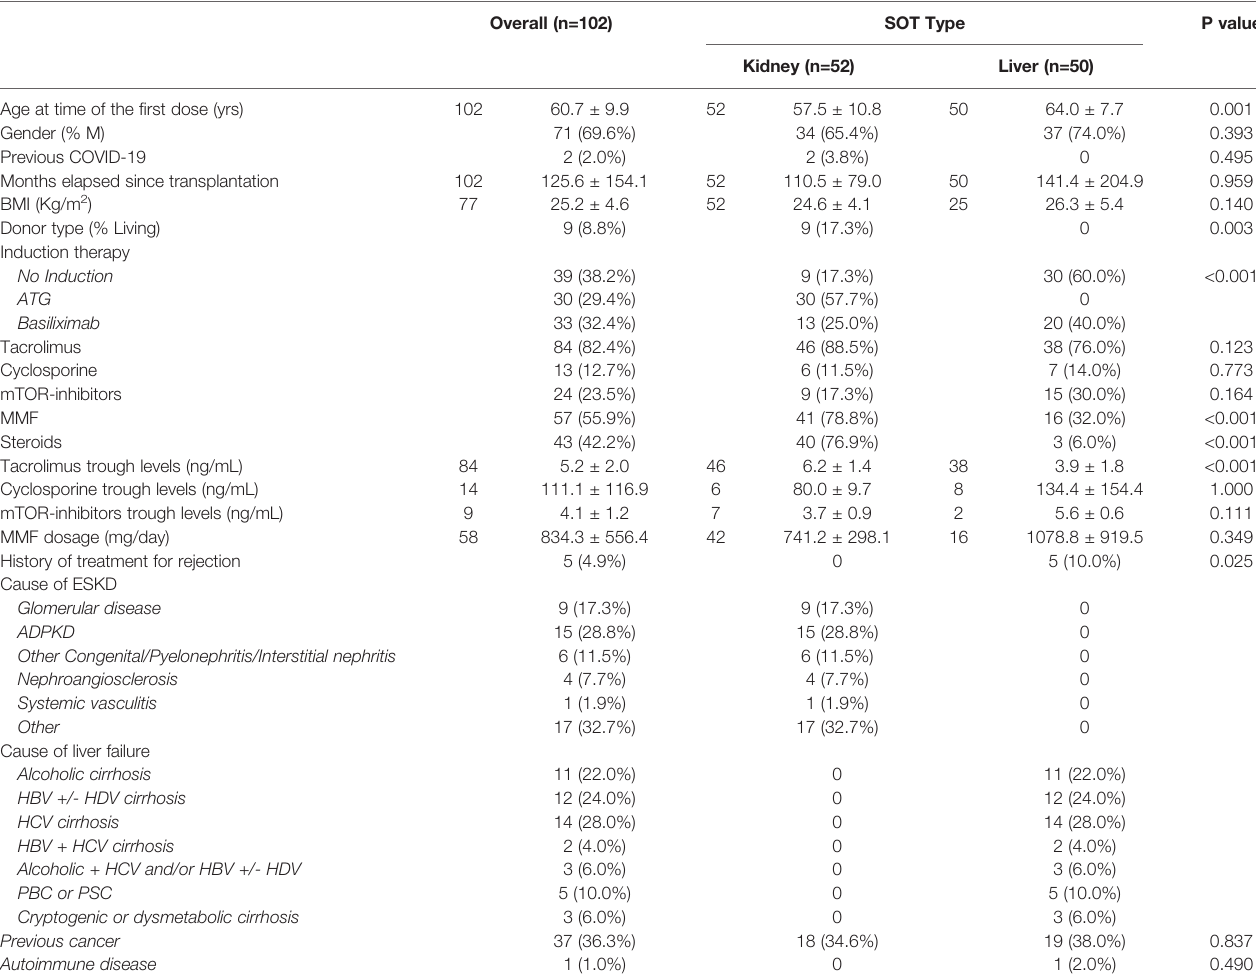
TABLE 1 | Study population ’ s